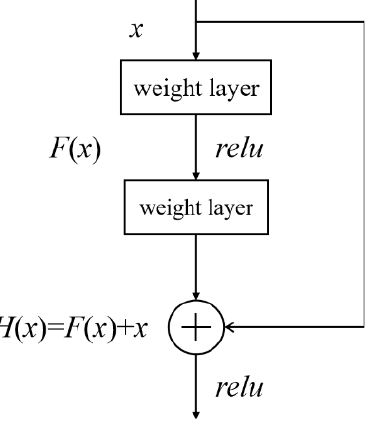
Figure 6. Residual connection